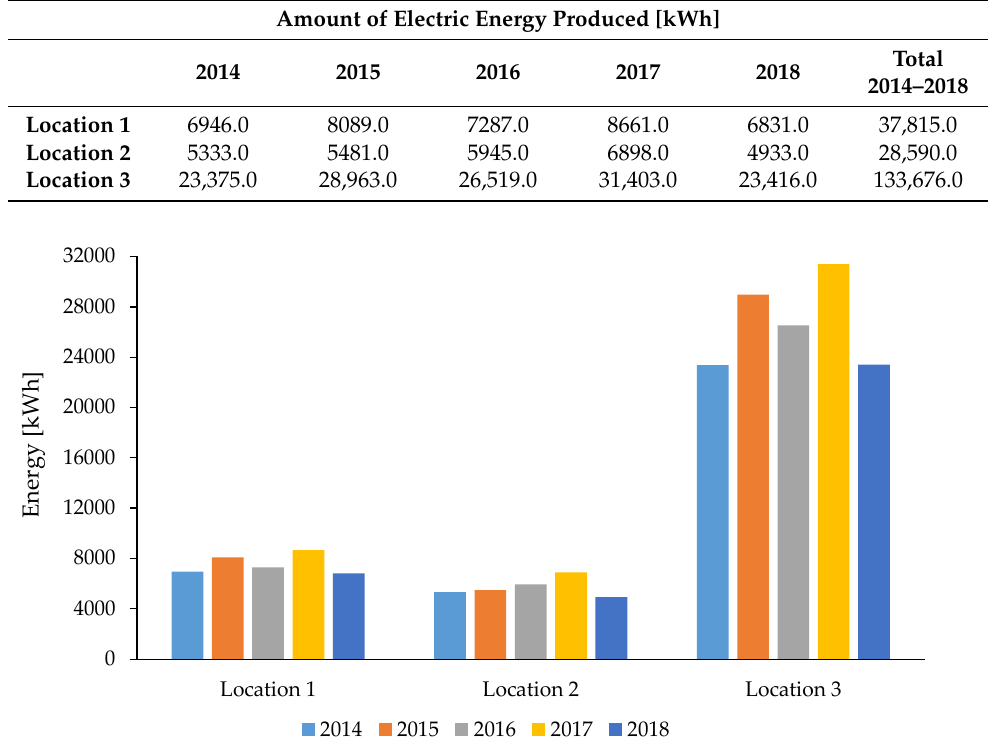
Figure 11. Energy yield comparison among the three locations. Table 5. Economic comparison of selected locations–simulation results.